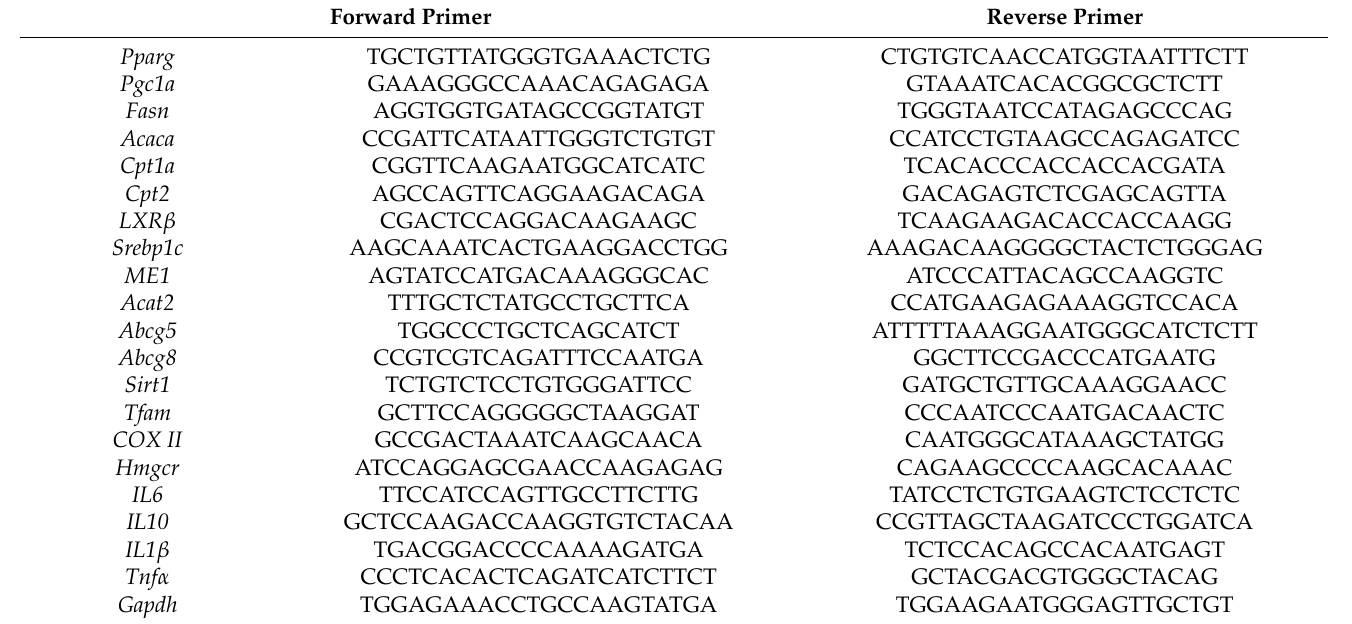
Table 1. Primer sequences that were used for semi-quantitative RT-PCR